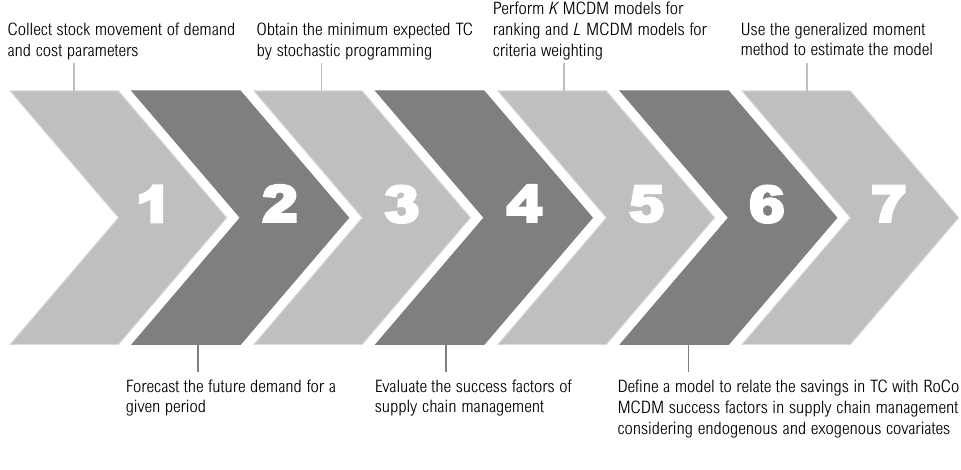
Figure 1. Proposed